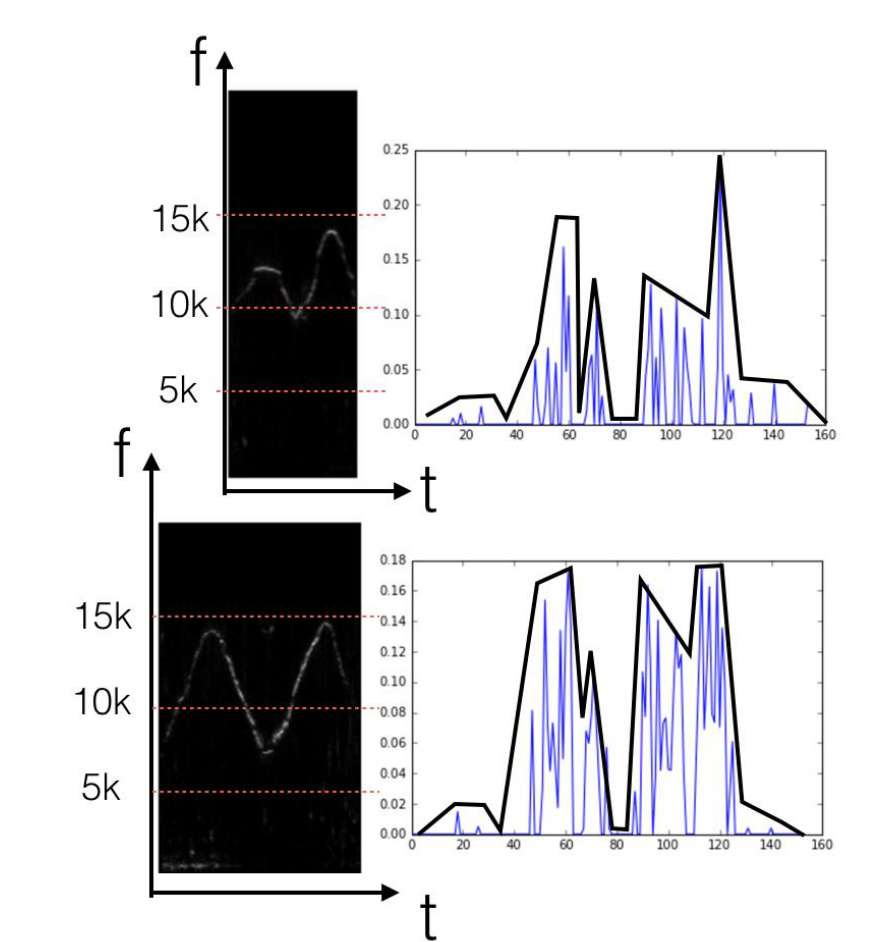
Figure 7. We wish to create a system that is insensitive to absolute frequencies when comparing vocalizations. We use convolutional features such that as long as some patch of the spectrogram at each time slice matches the feature, there will be a high response at that time. We then compare the response of all features over time using dynamic time warping to get a distance. Here, even though the bottom whistle shows much more variation in frequency, with the first peak almost reaching 15 kHz and the first trough reaching 7 kHz, the response to the feature through time is similar to the top whistle, resulting in a close distance score between the